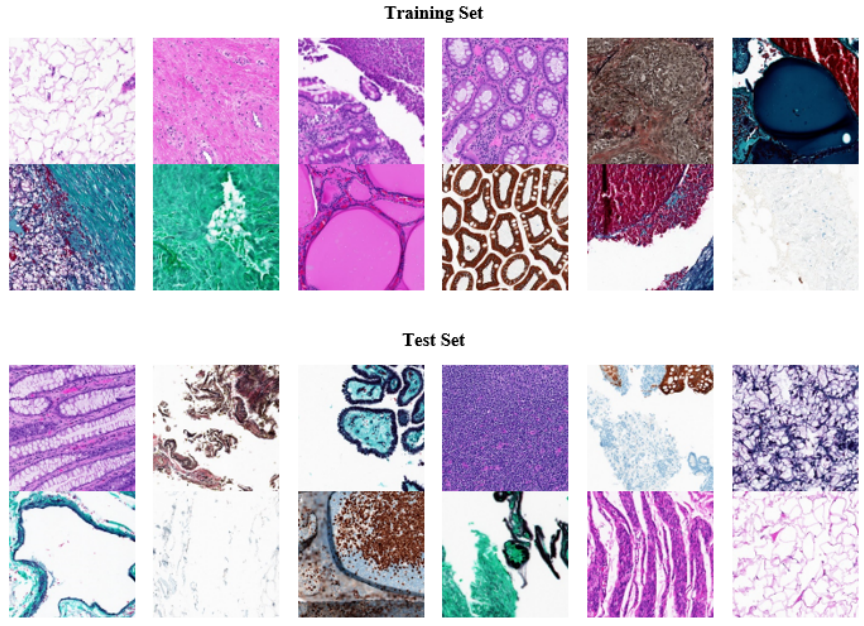
Figure 2. Random sample images from training set and test of Kimia Path24 dataset.